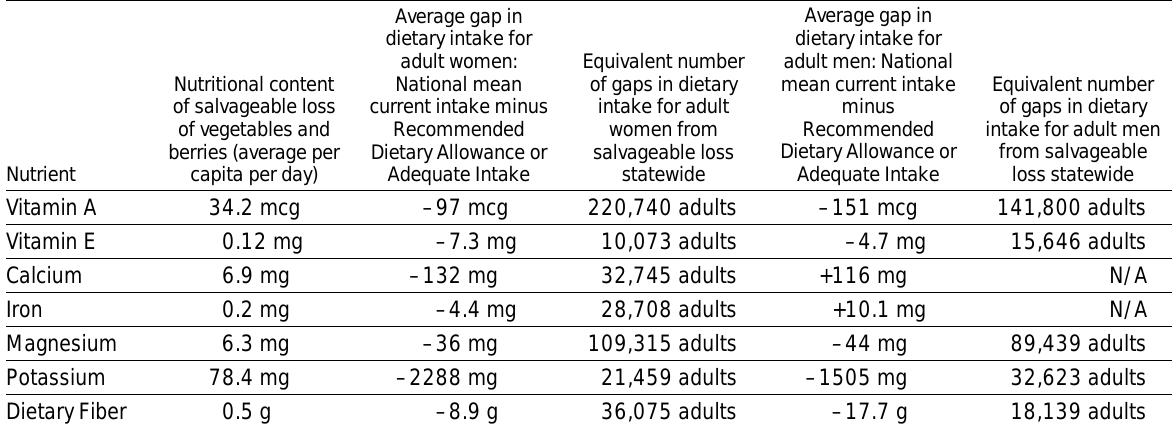
Table 5. Nutritional Content of Salvageable Vegetable and Berry Losses in Vermont (Modeled), for Selected Nutrients